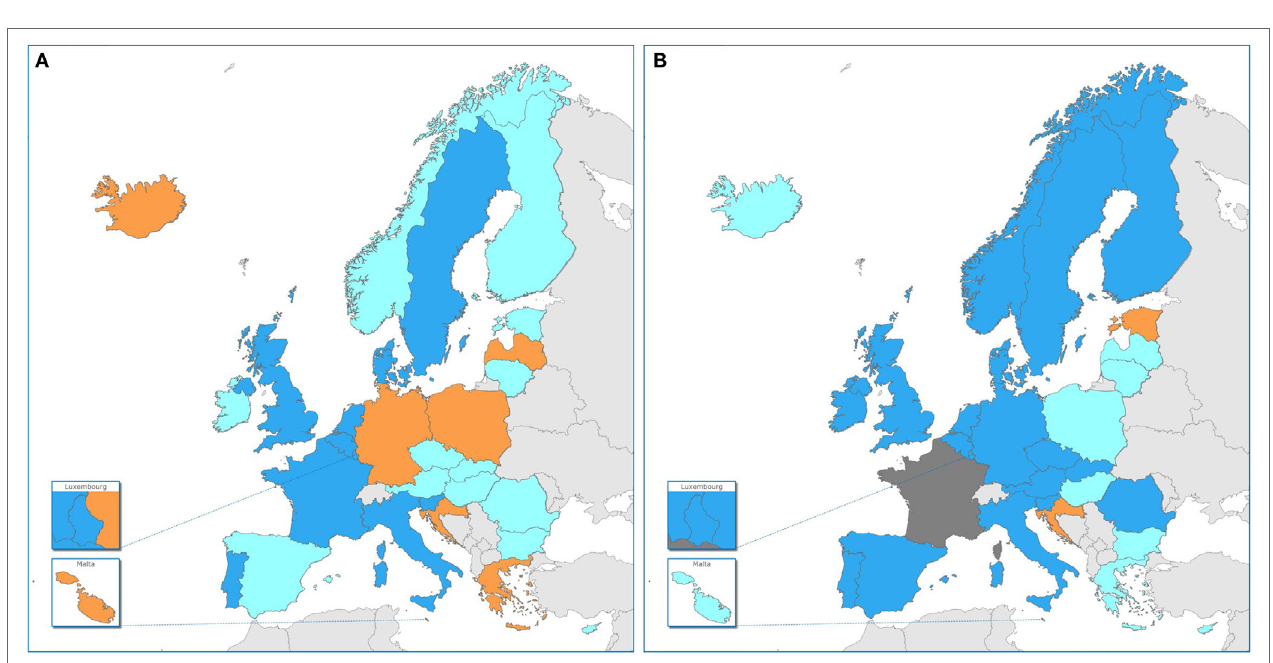
FigUre 2 | Use of whole-genome sequencing (WGS)-based typing of human pathogens in Public Health Reference Laboratories for routine national surveillance by country in the EU/EEA, 2015–16. Dark blue: WGS-based typing used routinely of at least one human pathogen; light blue: national plan in place/in progress for WGS-based typing for surveillance of at least one human pathogen by 2018; orange: no use in 2016 nor national plan for use by 2018; dark gray: no information. (a) 2015 data, cross-validated with EULabCap report (15) and (b) 2016 data.